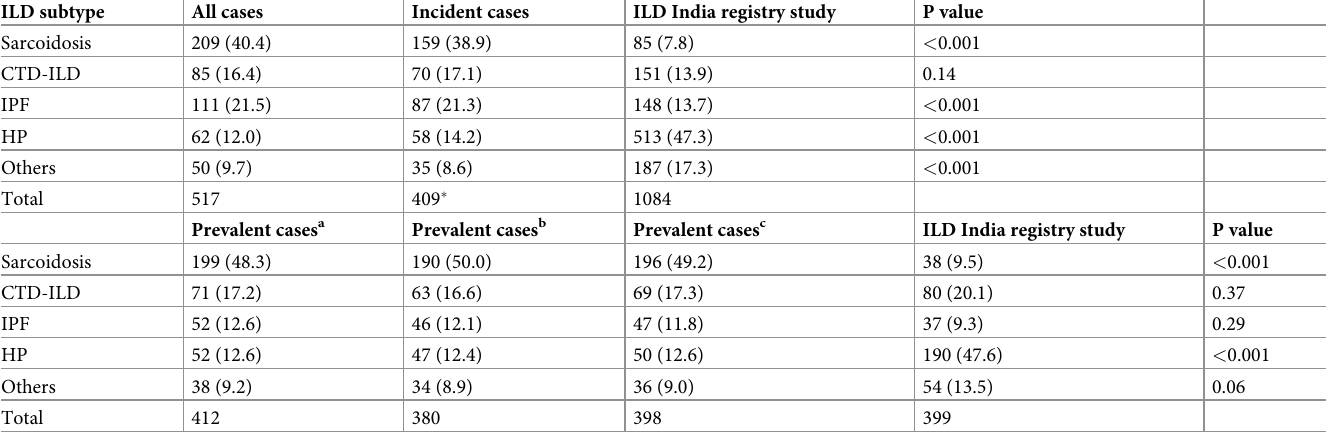
Table 4. Comparison of the spectrum of interstitial lung diseases amongst incident and prevalent cases and year-wise distribution of incident cases in the Tricity region.